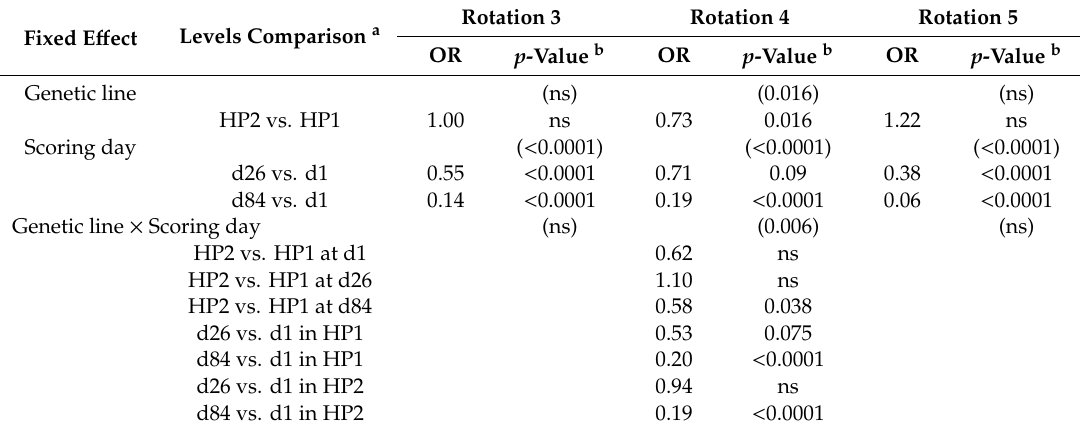
Table 2. Summary of the impact of genetic line (HP2 vs. HP1), scoring day (d1, d26, and d84) and their interaction on FRONT body lesion scores within each rotation (3, 4, and 5).